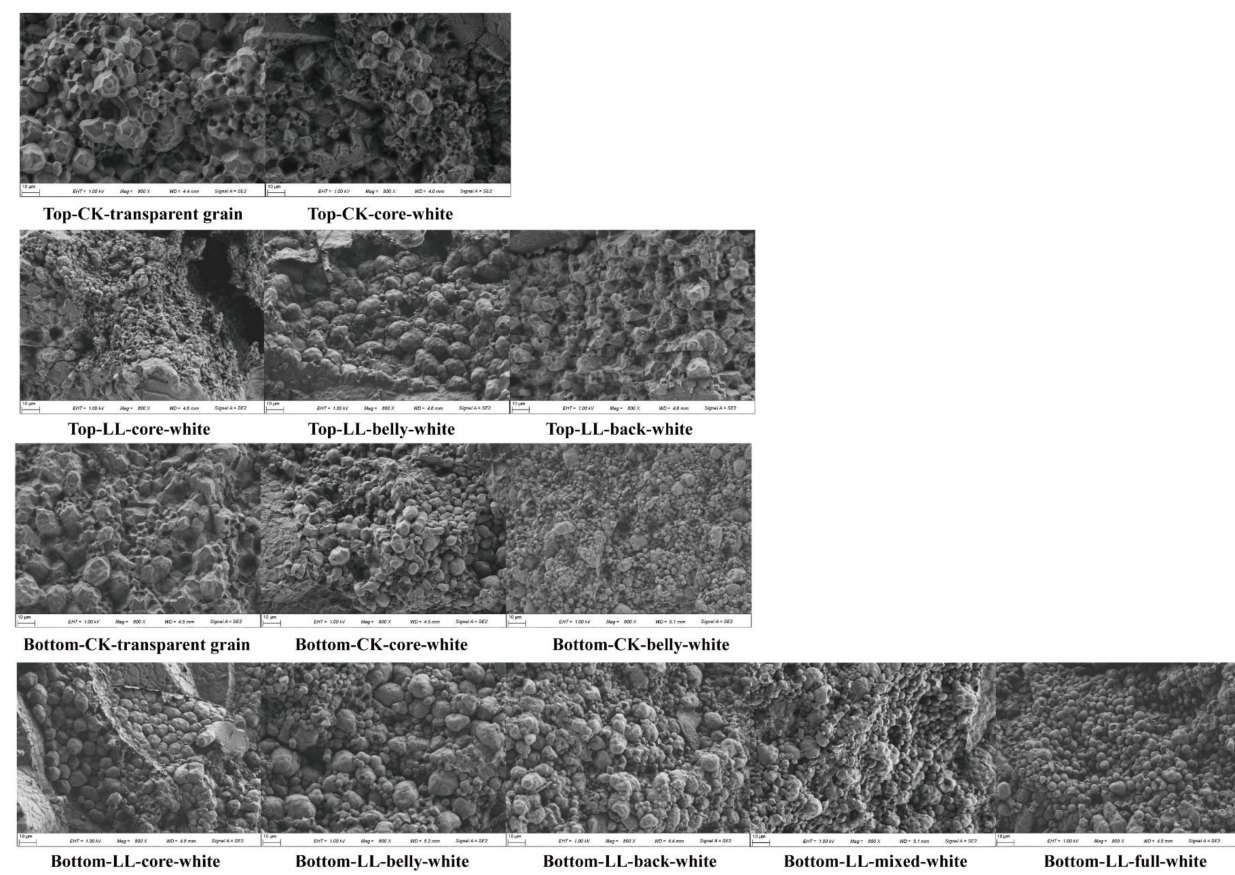
Figure 2. Changes in the microstructure of the grains in 2020. Top, top panicle part; bottom, bottom panicle part; CK, full sunlight control; LL, low light